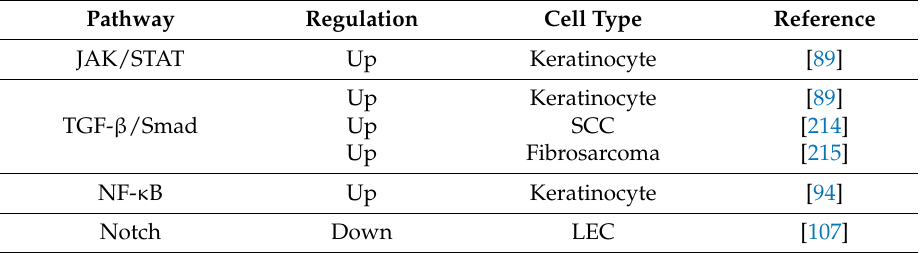
Table 4. Signaling pathways found to control podoplanin expression in different cell types.